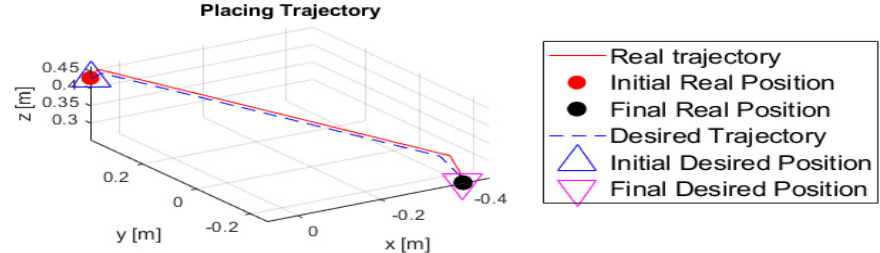
Figure 22. Real and desired trajectory of RM Cyton for transporting work-piece from ARS PeopleBot to P/RML, using inverse kinematics control and eye to hand VSS for precision positioning.